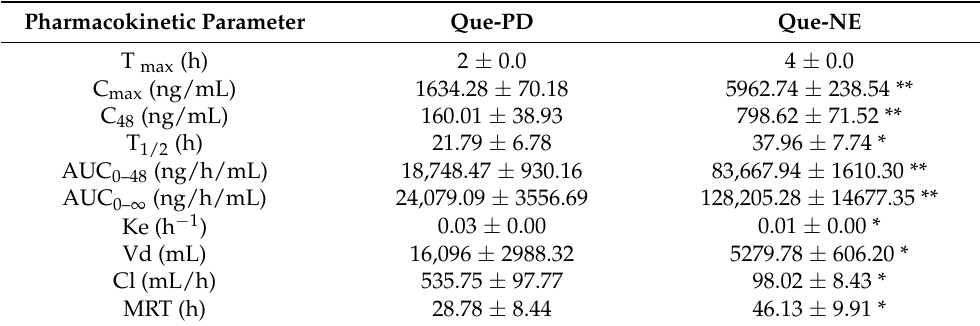
Table 5. Pharmacokinetic parameters of Que-NE and Que-PD after oral administration (50 mg/kg BW).